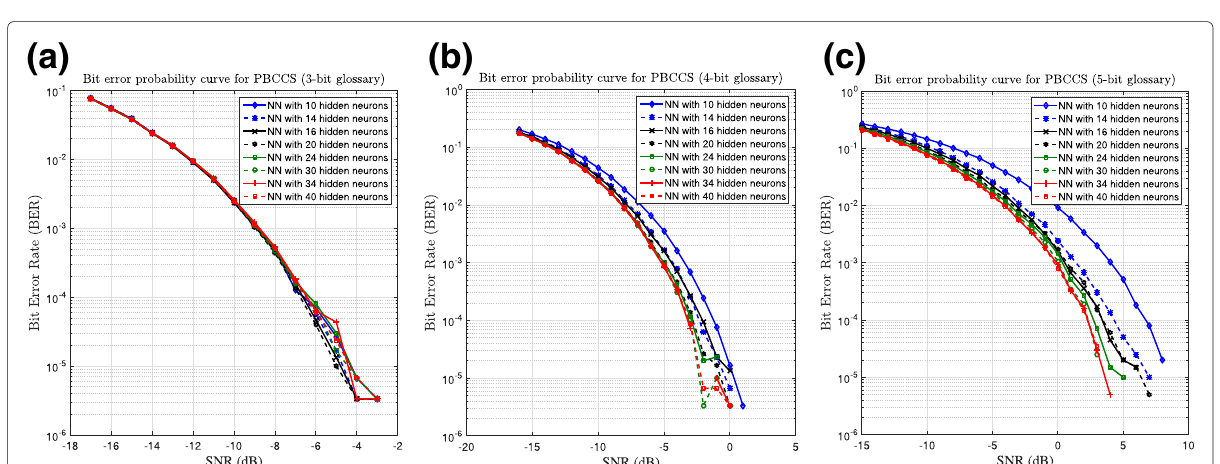
Fig. 11 Bit error rate for three different glossaries in an AWGN channel. Each curve represents the number of neurons at the hidden layer. a with 3-bit glossary, b with 4-bit glossary, c with 5-bit